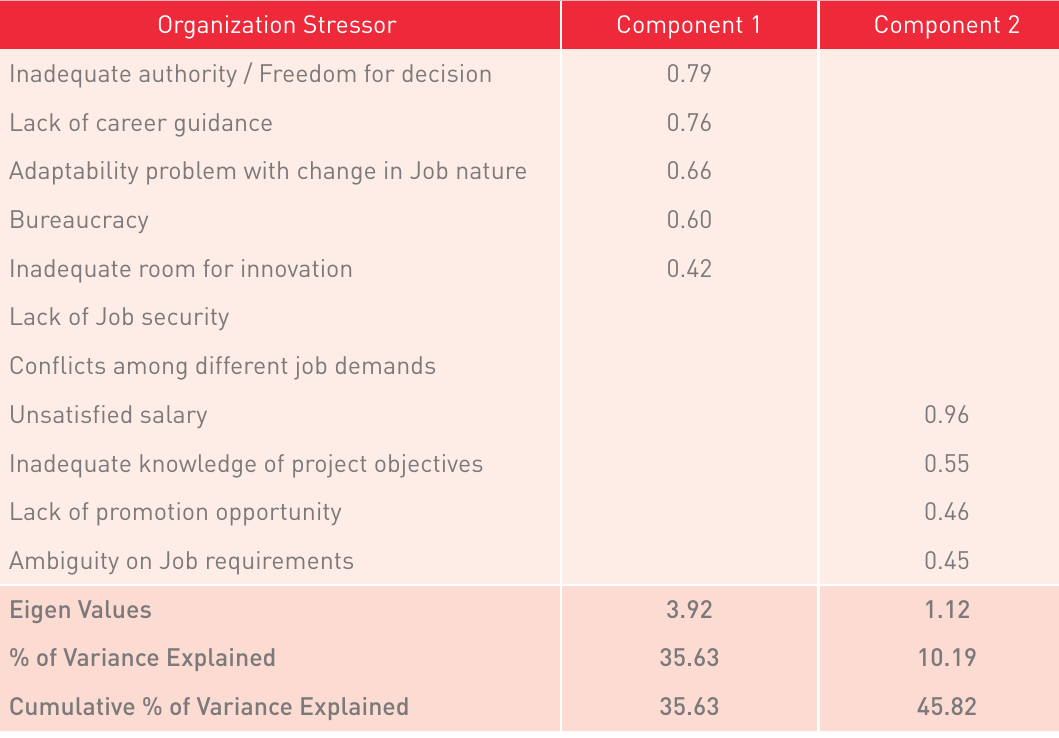
Exploratory Factor Analysis for Organisation Stressor